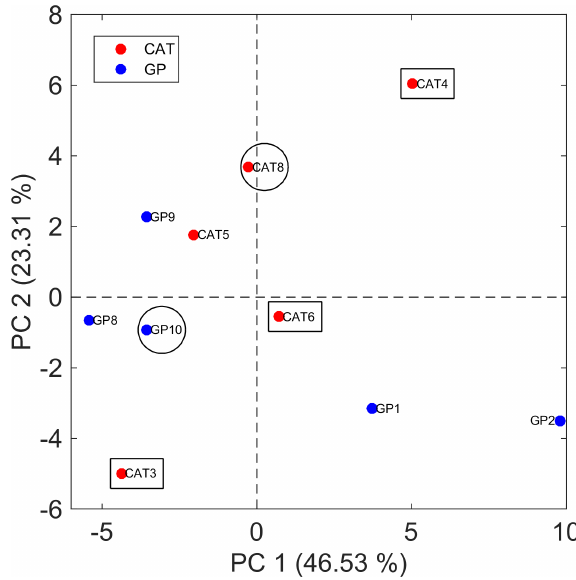
Figure 5. Bidimensional PCA score plot for SML samples using the matrix with 51 features for averaged technical replicates. Samples that were evaluated for particle formation during the Cabo Verde field campaign are indicated with circles (led to SOA formation) and rectangles (did not lead to SOA